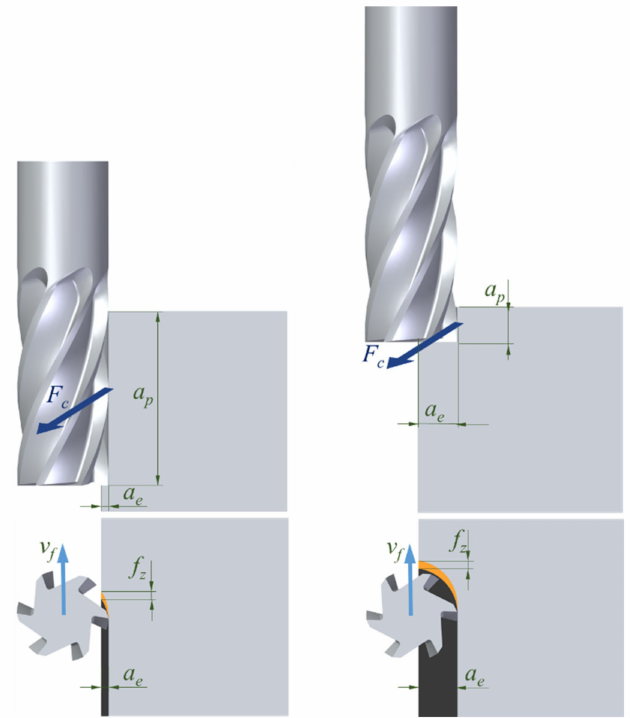
Figure 1. Relation between a p and a e for the same section.